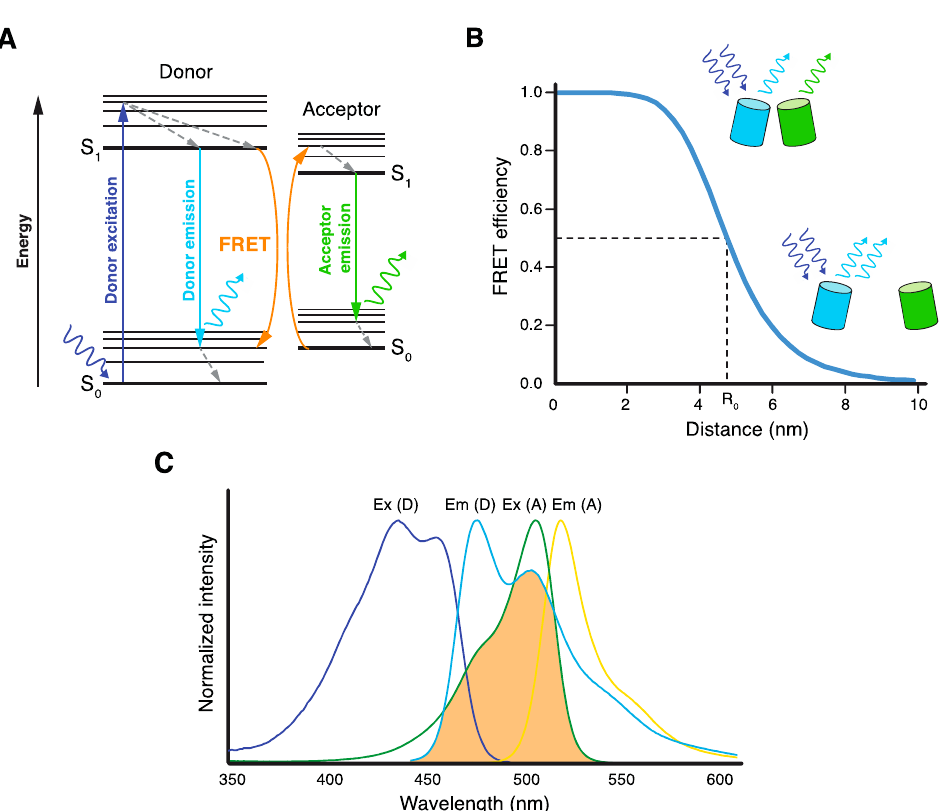
Figure 1. Basic principles of Förster resonance energy transfer (FRET). ( A ) Jablonski diagram illustrating excitation and emission of the donor fluorophore and FRET between the donor and acceptor fluorophores, resulting in acceptor emission. ( B ) Dependence of FRET efficiency on the distance R between donor and acceptor molecules. Förster radius R 0 is the distance at which half of the energy of the excited donor is transferred by FRET. ( C ) Excitation/absorption (Ex) and emission (Em) spectra of mTurquoise2 donor (D) and mNeonGreen acceptor (A) FRET pair. Spectral overlap between mTurquoise2 emission and mNeonGreen excitation spectra, which is essential for FRET, is highlighted in orange.